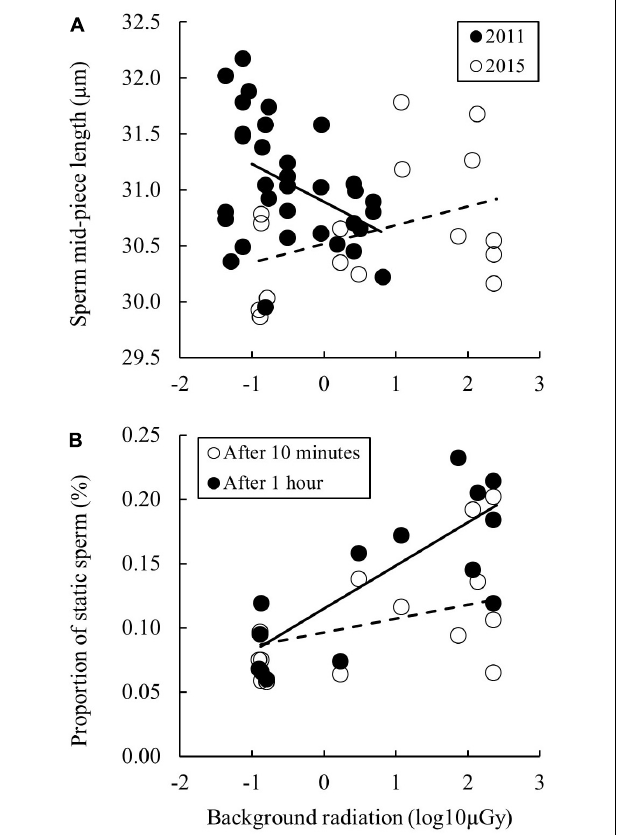
FIGURE 2 | Figure showing how (A) sperm mid-piece length and (B) sperm mobility changes in male bank voles as a consequence of chronic exposure to radiation. In panel (A) data from 2015 (open symbols and dashed line) and 2011 (filled symbols and solid line) are plotted, while in panel (B) the first measurement (open symbols and dashed line) was taken after 10 min of incubation and the second (filled symbols and solid line) after 60 min of incubation. Lines represent predicted values from the mixed models, and sample sizes were 49 males in (A) and 14 males in (B)